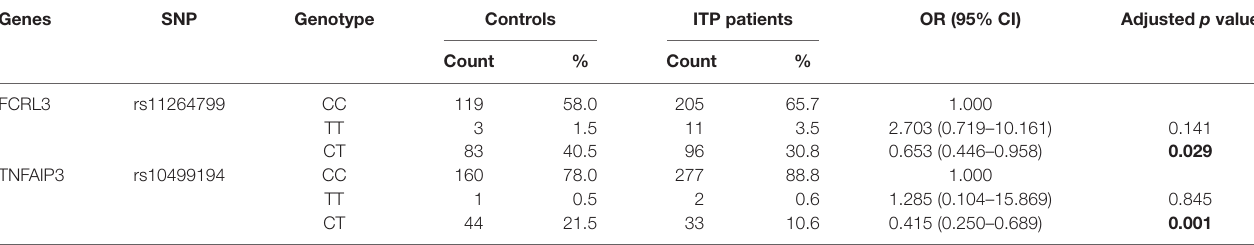
TaBle 4 | Association between selected SNPs and ITP risk under codominant model. genes snP